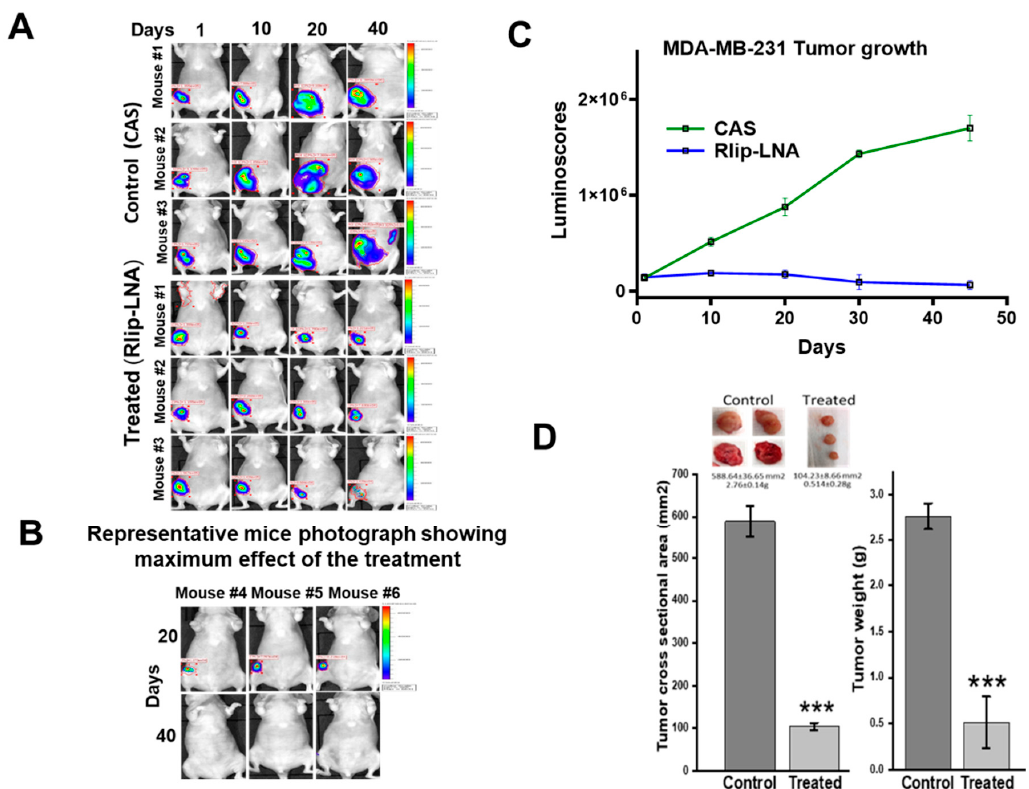
Figure 7. Effect of Rlip-LNA on growth rate of MDA-MB-231luc tumors. ( A ) Tumor burden was monitored via the luminoscore. Cells were injected as described in the Materials and Methods. Five mice per group were used and the experiment was repeated once. Seven drug injections were given. Control mice received the same number of injections of CAS in an equivalent volume (200 μ L). Images shown are from three mice from each group from Day 10 to the end of study. As seen, the effect of Rlip-LNA on the luminoscore was very significant on Day 40. ( B ) Panel shows the images of the three Rlip-LNA-treated mice that showed the greatest effect of treatment at Days 20 and 40. Disease was undetectable by the study endpoint. ( C ) Plot shows weekly tumor growth as measured by IVIS imaging, and units are in luminoscores for each group. Rlip-LNA-treated mice showed significant (*** p < 0.001) reduction in luminescence at each time point. ( D ) Histogram shows the tumor cross-sectional areas and tumor weights at the end of the study. Results are reported as mean ± SD. *** p < 0.001, as compared to the untreated group of mice, as analyzed by two-tailed Student’s t -test .